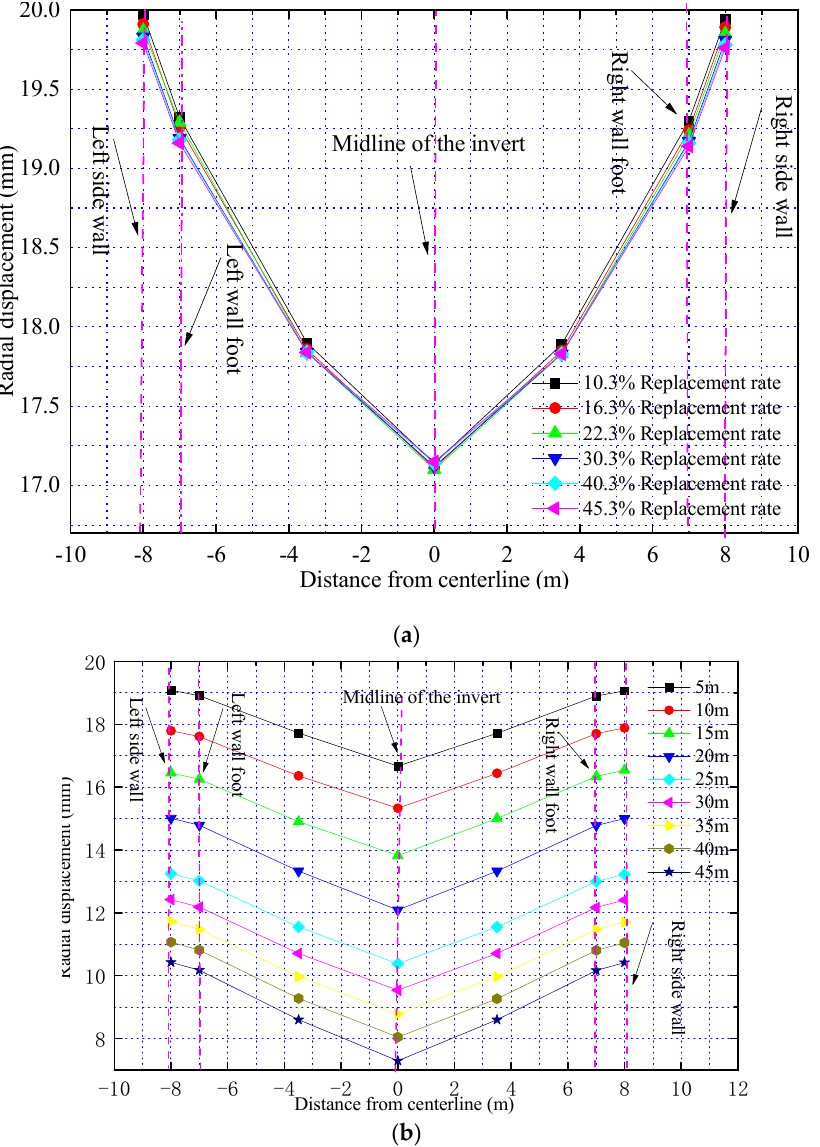
Figure 11. Variation law of base settlement under different replacement rates and pile lengths: ( a ) Replacement rate; ( b ) Pile length.